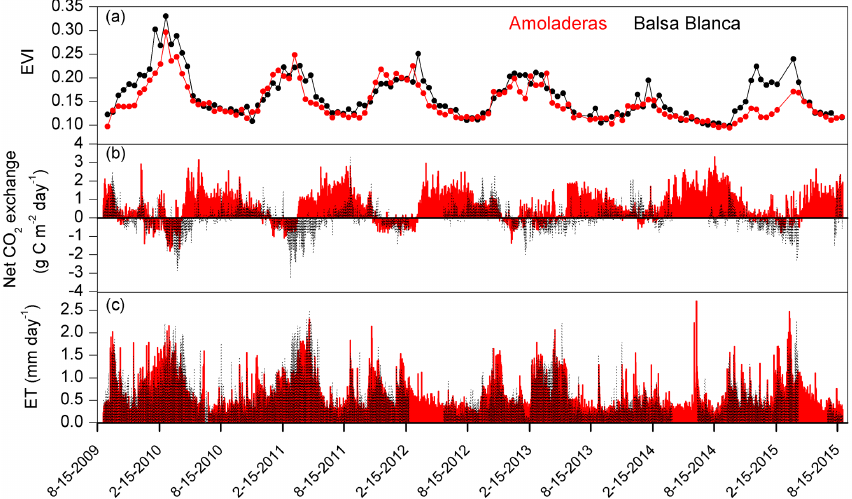
Figure 6. Time series of (a) enhanced vegetation index (EVI), (b) daily net CO 2 exchange and (c) daily evapotranspiration fluxes measured in Amoladeras (red lines and dots) and Balsa Blanca (black lines and dots) over 6 hydrological years (2009–2015). Long-term data losses correspond to periods of several months when ET and CO 2 fluxes are